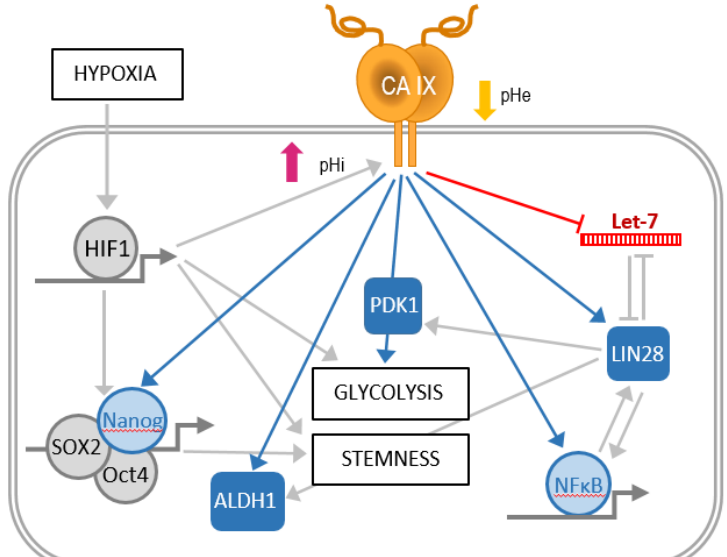
Figure 6. Schematic illustration of the proposed CAIX contribution to metabolic adaptation and stemness of cancer cells. Manipulation of CAIX levels via RNA interference, gene editing, or ectopic expression in hypoxic breast cancer cells supports the role of CAIX in the downregulation of let-7 microRNA family members, resulting in upregulation of LIN28 RNA-binding protein and activation of NFκB transcription factor. The expression of CAIX is also associated with increased level and activation of PDK1 kinase, which is important for the glycolytic metabolism. Moreover, CAIX contributes to higher levels of SOX2, Oct4, and Nanog transcription factors and ALDH1 protein participating in cancer cell stemness. Interestingly, CAIX, HIF-1, and LIN28 pathways are interconnected through multiple relationships and feedback loops, suggesting their complex regulatory network, in which CAIX can presumably play a role as a mediator of responses to hypoxia and acidosis. Color coding: Molecules in blue color were identified as positively regulated by CAIX, the one in red color is negatively regulated by CAIX. The arrows indicate upregulation, while the T line indicates downregulation. Gray arrows represent relationships already known from the literature, while blue arrows and the red T line represents newly identified relationships described in this study.